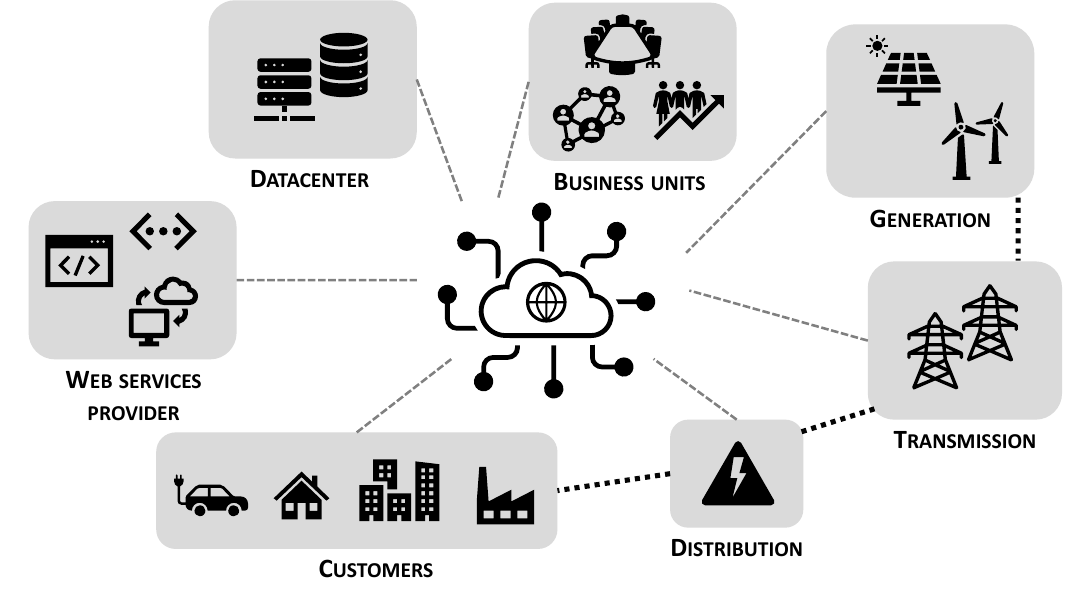
Figure 1. Smart Grid energy market.